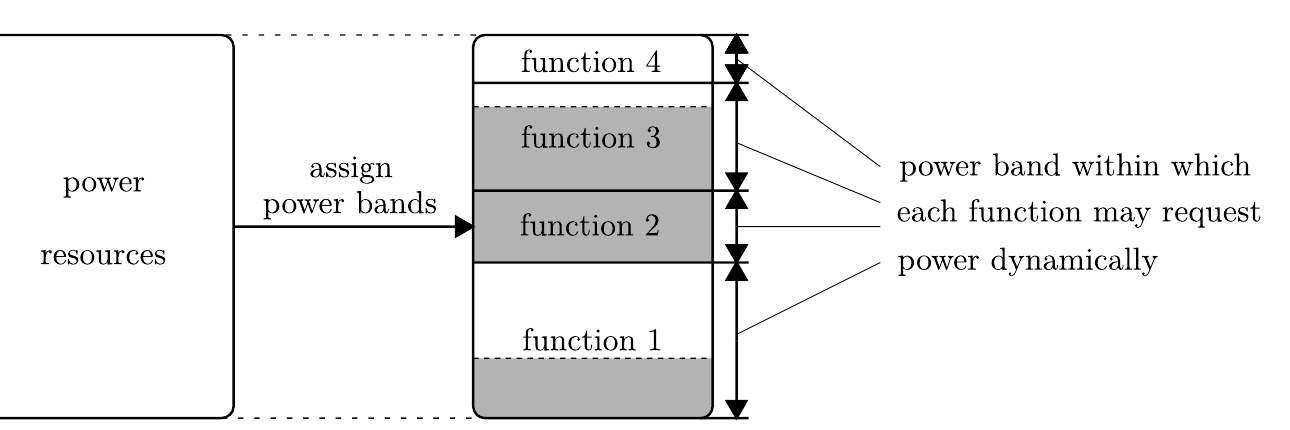
Figure 3. Concept of allocation of virtual BESS for each function on the example of static assignment of power bands for each function in a specific time slot. The grey color marks the currently occupied share of the power band of the corresponding